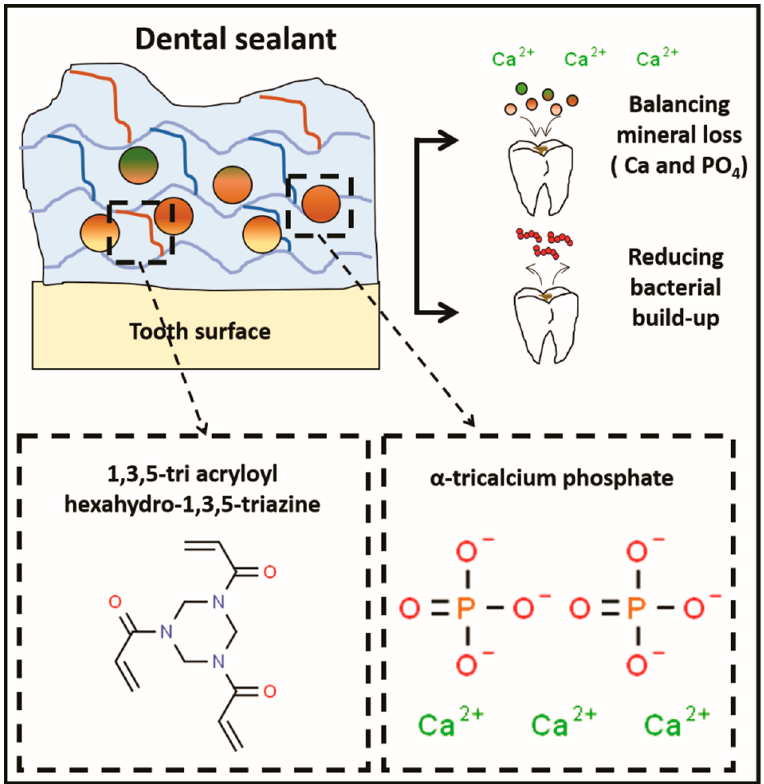
Figure 3. Schematic draw of the dental sealant formulated and analyzed in the present research, containing an antibacterial and a bioactive agent.